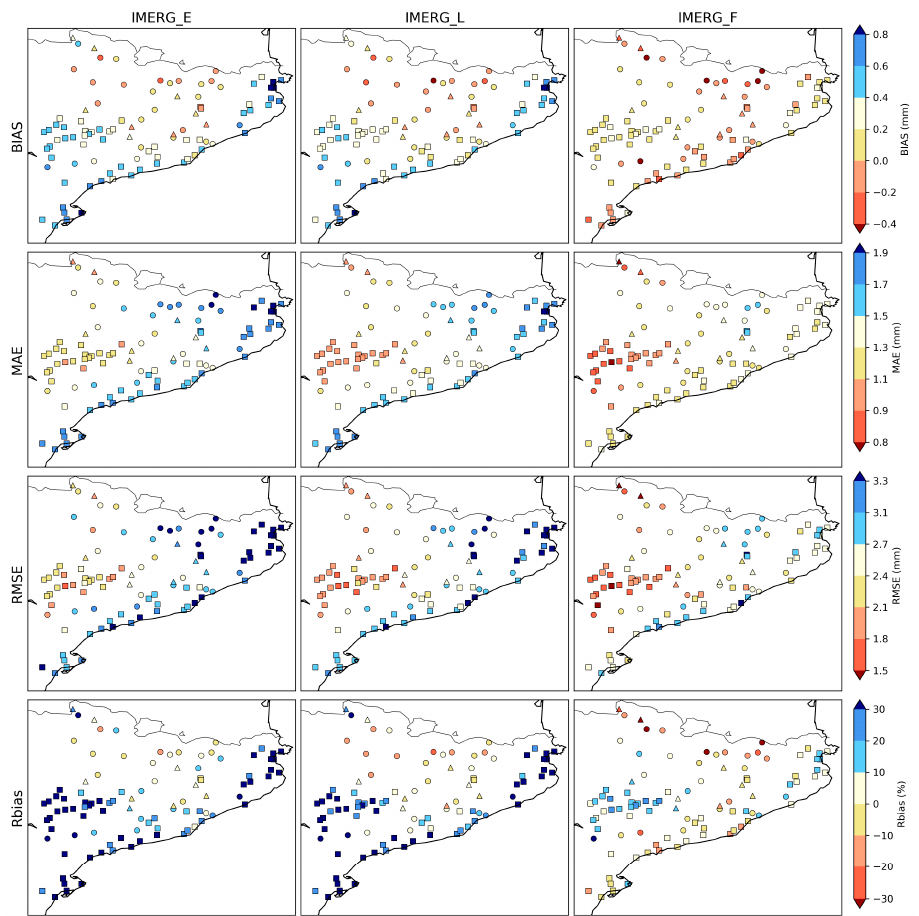
Figure 8. Distribution of Bias, MAE, RMS and Rbias errors at each station point and according to the orography type where they are located: Ridgetop (triangle), Flat (square), Valley (circle).